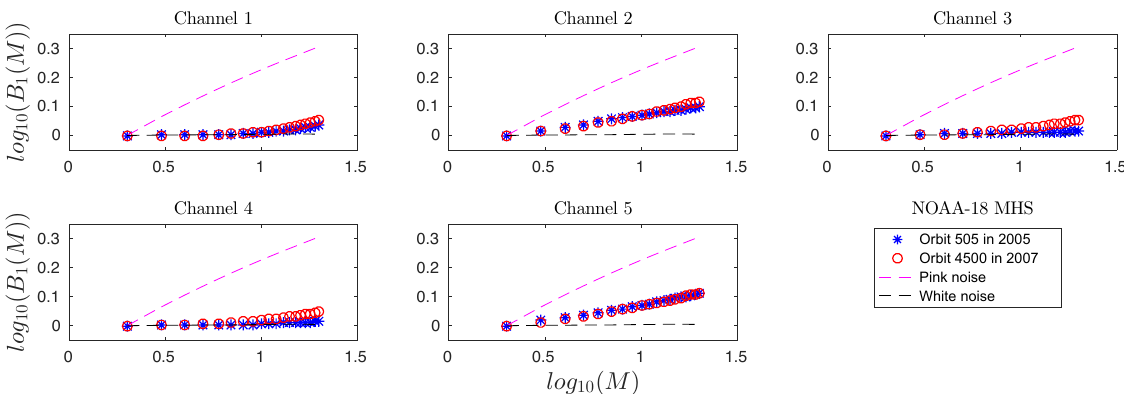
Figure 2. The bias functions B 1 (M) per channel for the orbits 505 of the year 2005 and 4500 of the year 2007 for MHS on NOAA-18.